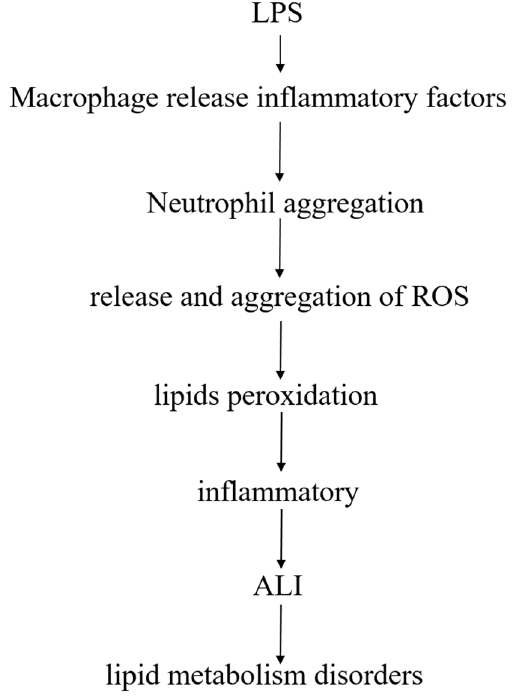
Figure 9. The relationship between lipids and LPS-induced ALI.